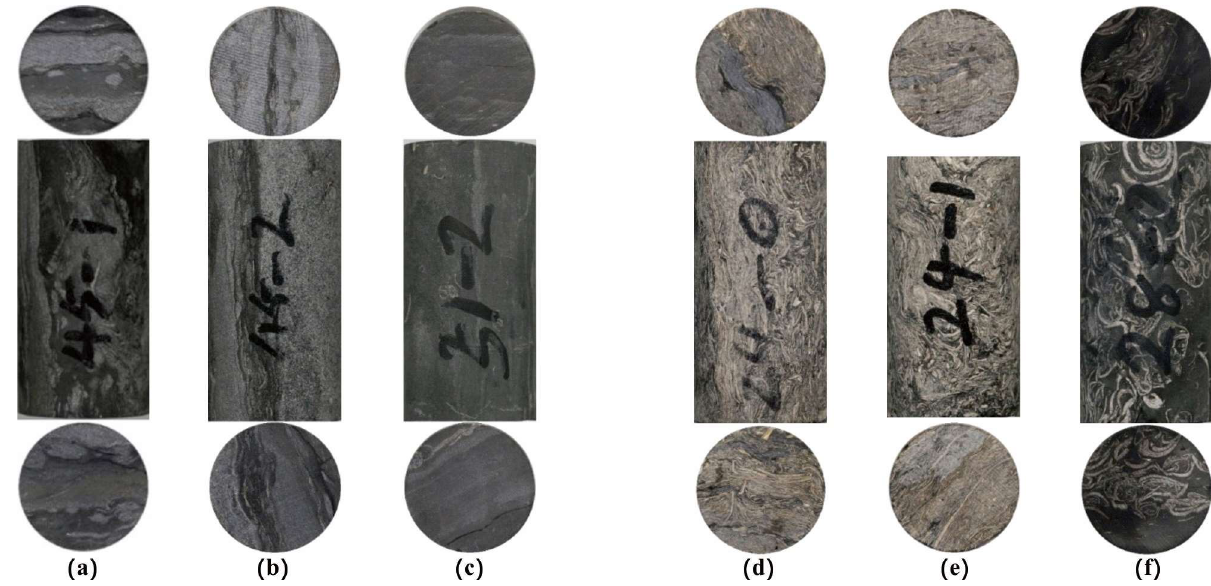
Figure 13. Shale samples with different shell contents. ( a – c ) Low shell content. ( d – f ) High shell content.